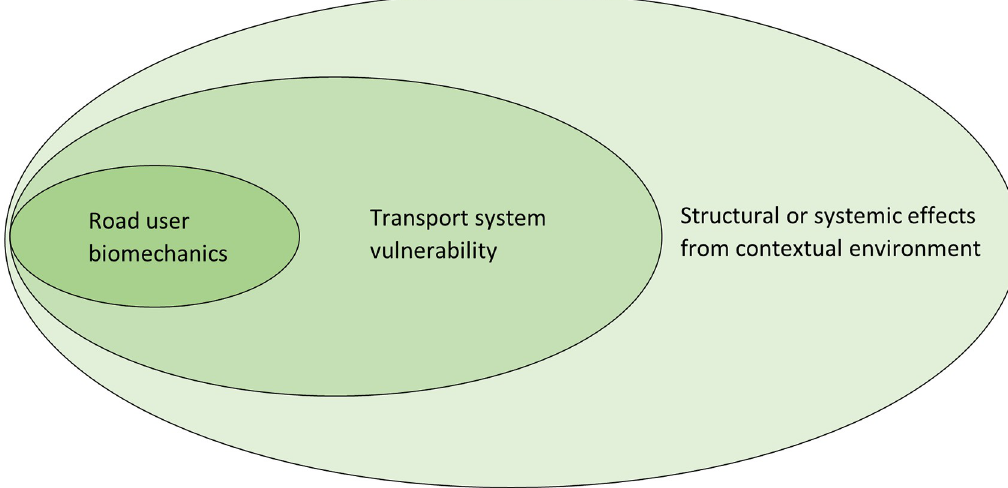
Fig 1. Nested effects pertaining to road users, the transport system and the contextual environment on a proximal to distal continuum.